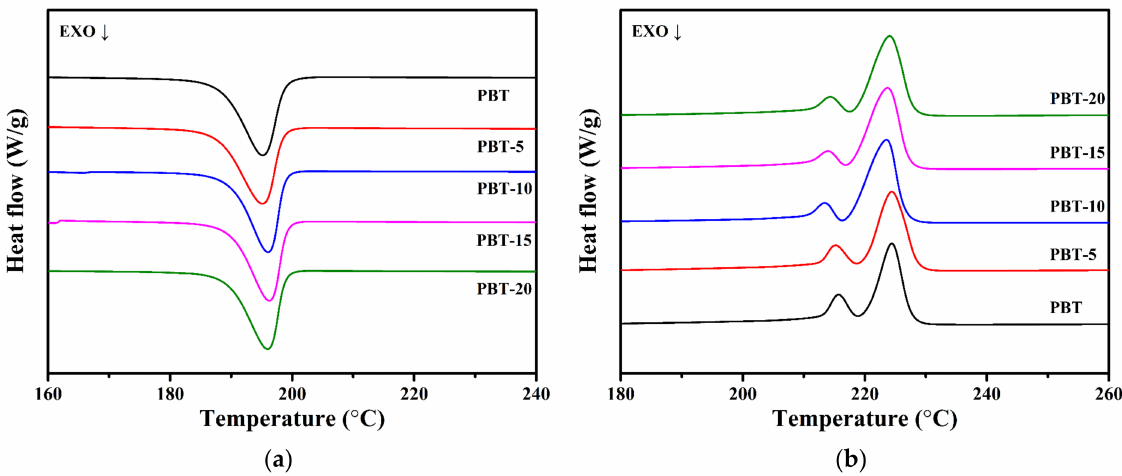
Figure 5. ( a ) DSC cooling and ( b ) second heating curves for PBT and PBT/AMWs